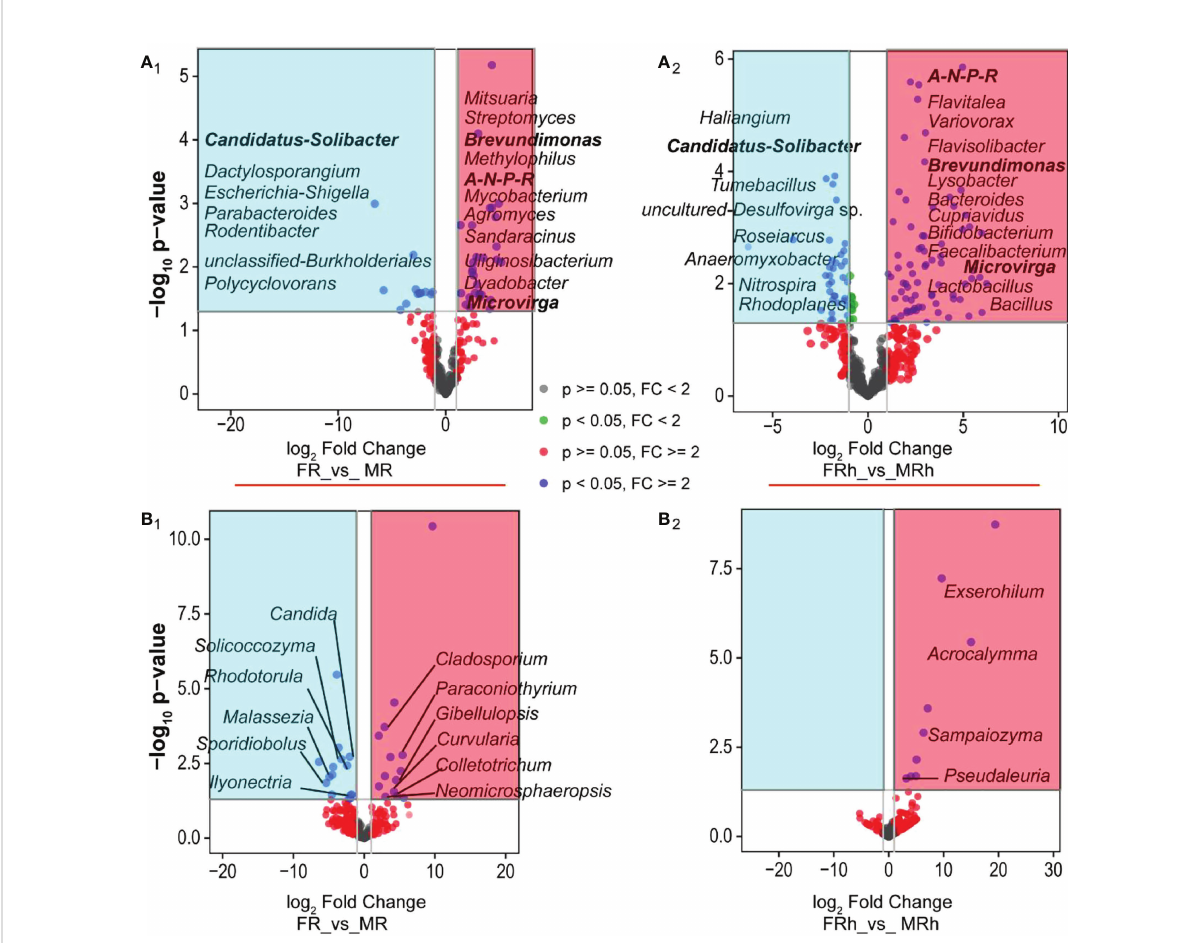
FIGURE 5 Volcano plots depicting the differential abundance of microbial communities (genus level) in the roots and rhizosphere soils of the female and male. (A) , bacteria; (B) , fungi; 1, roots; 2, rhizosphere soils. A-N-P-R is the abbreviation of Allorhizobium-Neorhizobium-Pararhizobium- Rhizobium . The spots in the blue background represented signi fi cantly up-regulated in the females, while the spots in the red background were signi fi cantly up-regulated in the males. The bold black font indicated the signi fi cantly changed microorganisms in both male and female papaya roots and rhizosphere